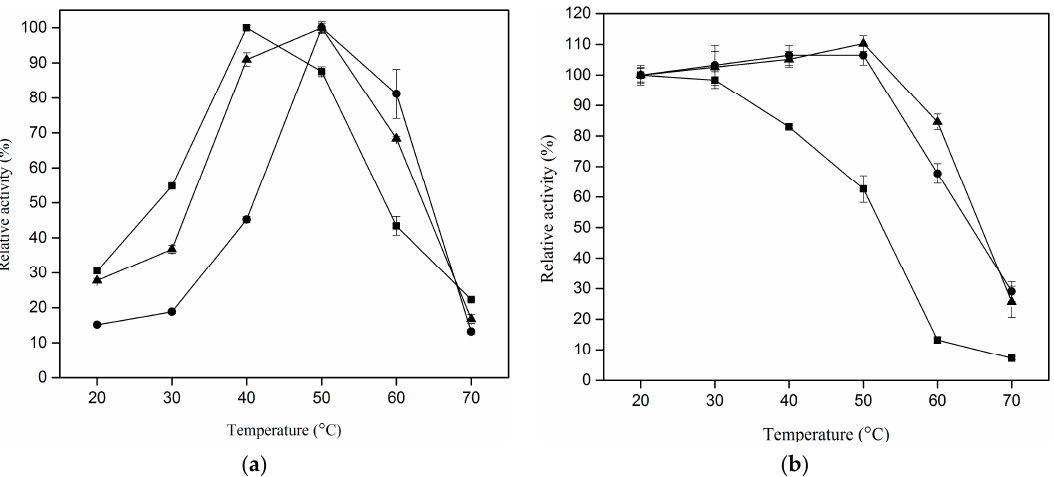
Figure 4. Temperature profile of elastase and its CLEA derivatives. ( a ) The e ff ect of temperature on the optimum temperature of CLEA–elastase ( (cid:8) ) and CLEA–elastase formed with starch and BSA (CLEA–elastase–SB) ( (cid:78) ) in comparison with free elastase ( (cid:4) ); ( b ) thermal stability of CLEA–elastase ( (cid:8) ) and CLEA–elastase–SB ( (cid:78) ) in comparison with free elastase ( (cid:4) ). The experiment was conducted in triplicate and relative activities are presented as mean values ± standard error.